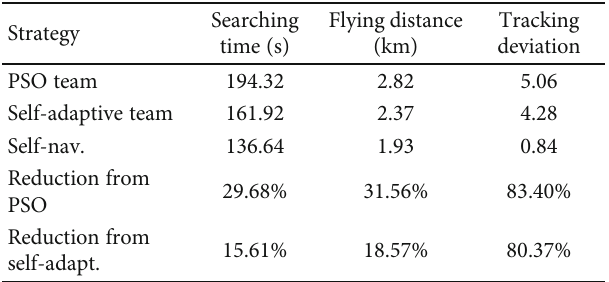
Table 4: Average reduction of searching time, fl ying distance, and tracking deviation observed in our proposed WSN-assisted navigation, compared to self-adaptive and PSO